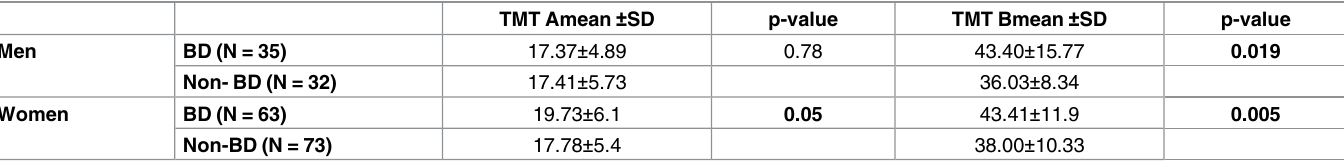
Table 3. Effect of Binge Drinking on TMT A and B stratified by